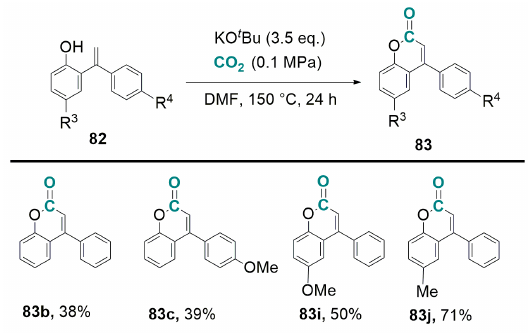
Scheme 65. Selected examples for carboxylation reactions of 2 ‐ (imidazo[1,2 ‐ a ]pyridine ‐ 2 ‐ yl)phenol derivatives followed by